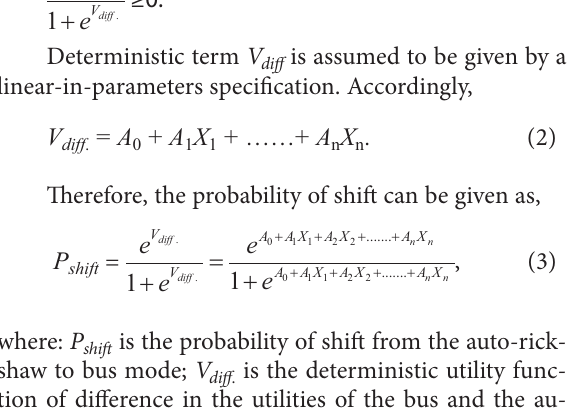
Fig. 1. Representative traffi c